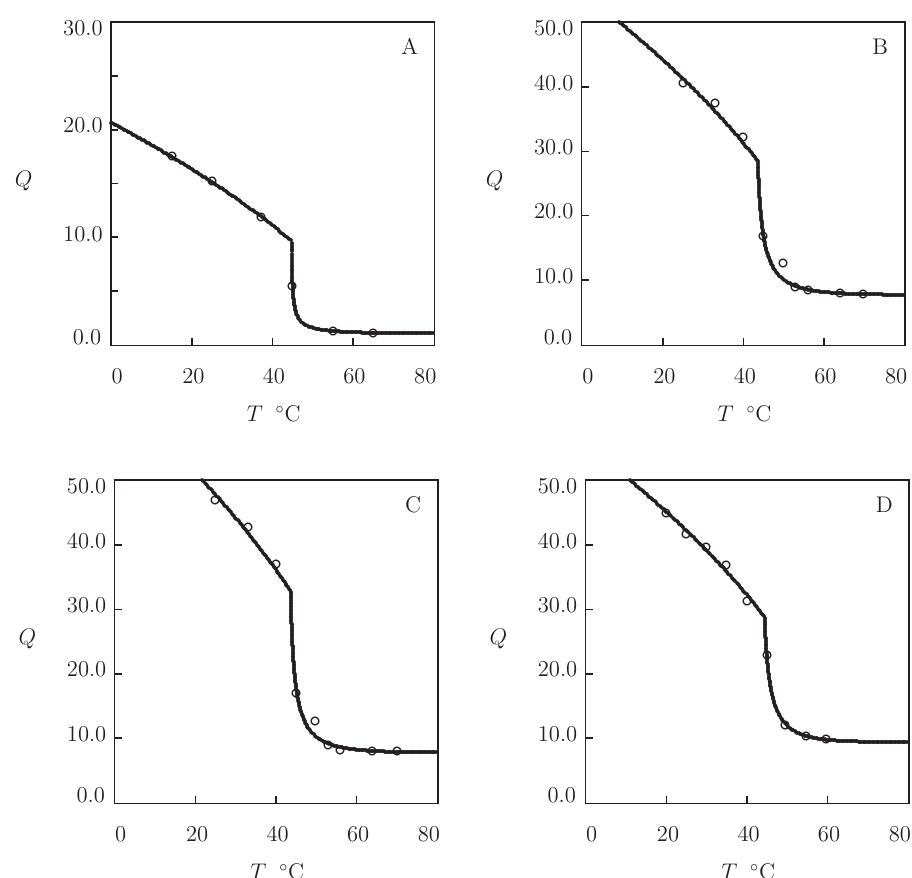
Figure 6. Degree of swelling Q versus temperature T . Circles: experimental data on PDMAEMA gels (( A ) [74], ( B ) [75], ( C ) [76], and ( D ) [77]). Solid lines: results of simulation. Observations in equilibrium swelling tests on PDMAEMA copolymer gels are reported in Figure 7 together with results of simulation with the material parameters reported in Table S7. Experimental data on poly( N , N -dimethylaminoethyl methacrylate-co-ethyl acrylamide) P(DMAEMA-EAAm) gel are presented in Figure 7A, and those on poly( N , N - dimethylaminoethyl methacrylate-co-acrylamide) P(DMAEMA-AAm) are depicted in Figure 7C. Both gels were synthesized by free radical cross-linking polymerization (15 h at 75 ◦ C) of solutions of comonomers (the total molar fraction of monomers 0.496 M, molar ratio ψ of EAAm monomers ranged from 0 to 0.1, and that of AAm monomers varied in the interval between 0 and 0.33) in a 1:1 ( v / v ) mixture of water and ethanol by using BIS (molar fraction with respect to monomers 1.8 10 − 3 ) as a cross-linker and AIBN as an × initiator (Cho et al. [77]). As AAm and EAAm are temperature-insensitive, Equation (21) is used to calculate the FH parameter of copolymer gels. Changes in VPTT with molar fraction of comonomers ψ are described by Equation (23) with ˜ χ = 0.68 for hydrophobic AAm monomers and ˜ χ = 2.26 for hydrophilic EAAm monomers. Figure 7B,D confirm − that Equation (23) predicts adequately the effect of ψ on VPTT of P(DMAEMA-EAAm) and P(DMAEMA-AAm) copolymer